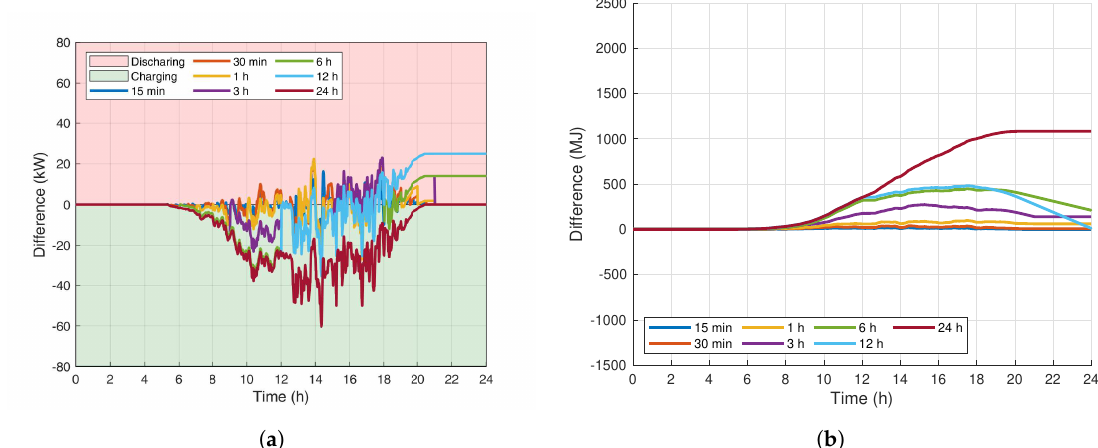
Figure A2. The resulting PV power and energy forecast differences that arise from the use of temperature and solar irradiance forecast when compared to the known truth atmospheric time series of the renewable asset assuming MPPT for the overcast sky conditions. ( a ) The overcast sky PV power forecast differences; ( b ) The overcast sky PV energy forecast